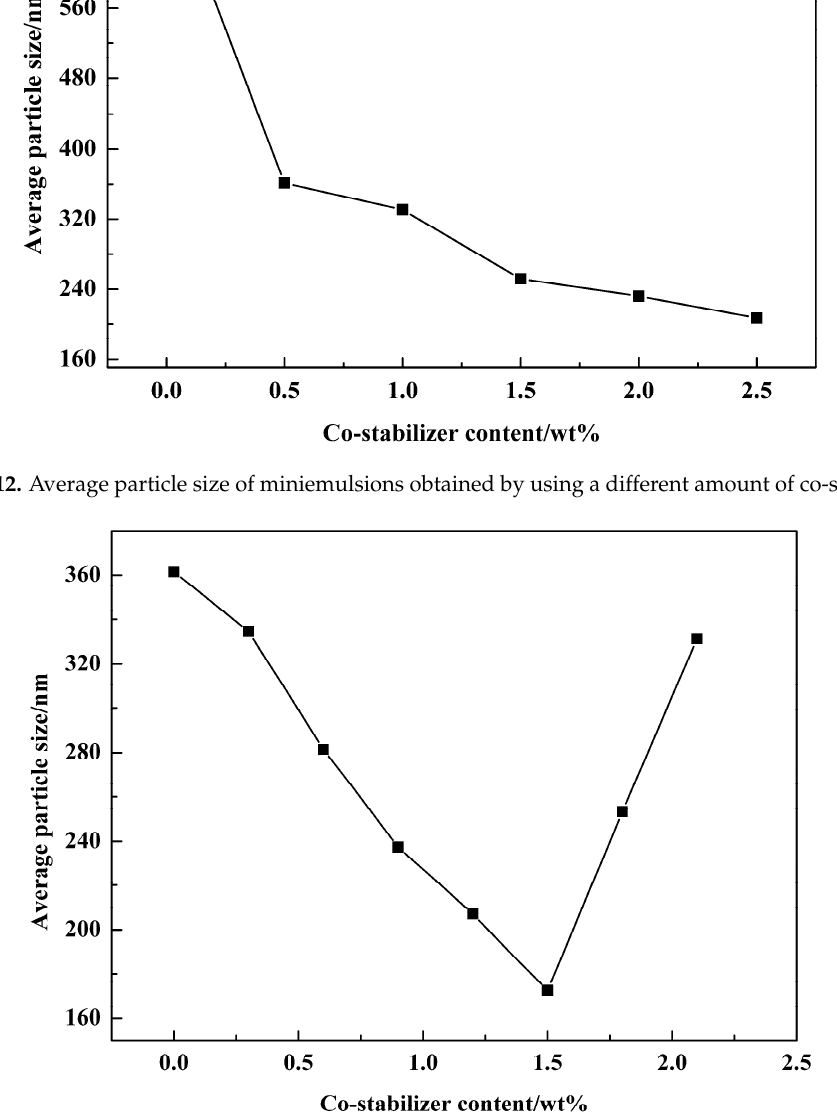
Figure 12. Average particle size of miniemulsions obtained by using a different amount of co-stabilizer.